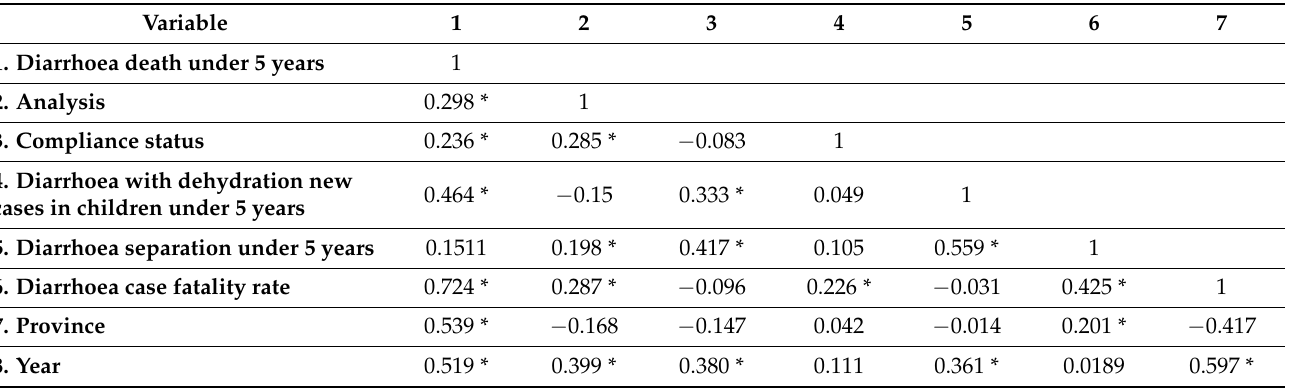
Table 3 indicates that microbial data compliance with SANS 241:2015 Edition 2 was positively associated with diarrhoea death under 5 years (r = 0.236). The diarrhoea case fatality rate was also positively associated with microbial data compliance with SANS 241:2015 Edition 2 (r = 0.226, p < 0.05). Diarrhoea with dehydration new cases in children under 5 years and diarrhoea separation for under 5 years did not seem to be associated with microbial water quality compliance over the study period. Table 3. Pearson’s Correlations.